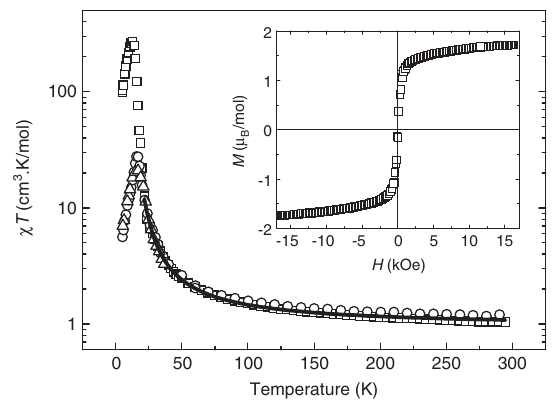
Figure 9: Magnetic behavior of the copper(II) compounds with bridging dicarboxylate anions with n = 4 alkane chains: ( ) meta- magnetic compound 4 , ( ) ferromagnetic compound 4 0 magnetic compound 4 . The magnetization at 4 K of 4 2 insert. The solid line corresponds to the fit to the S = ½ Heisenberg model described in the text.